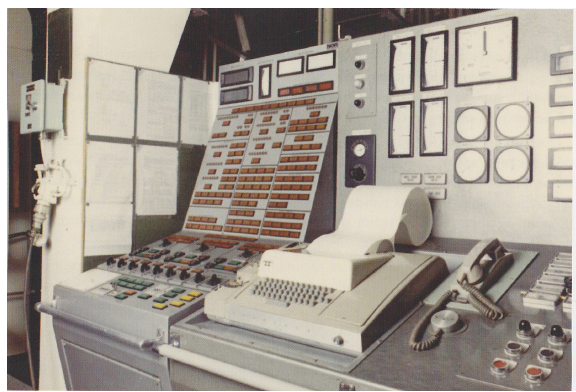
Figure 8: A prototype of a computer-based ship au- tomation system onboard the M/S